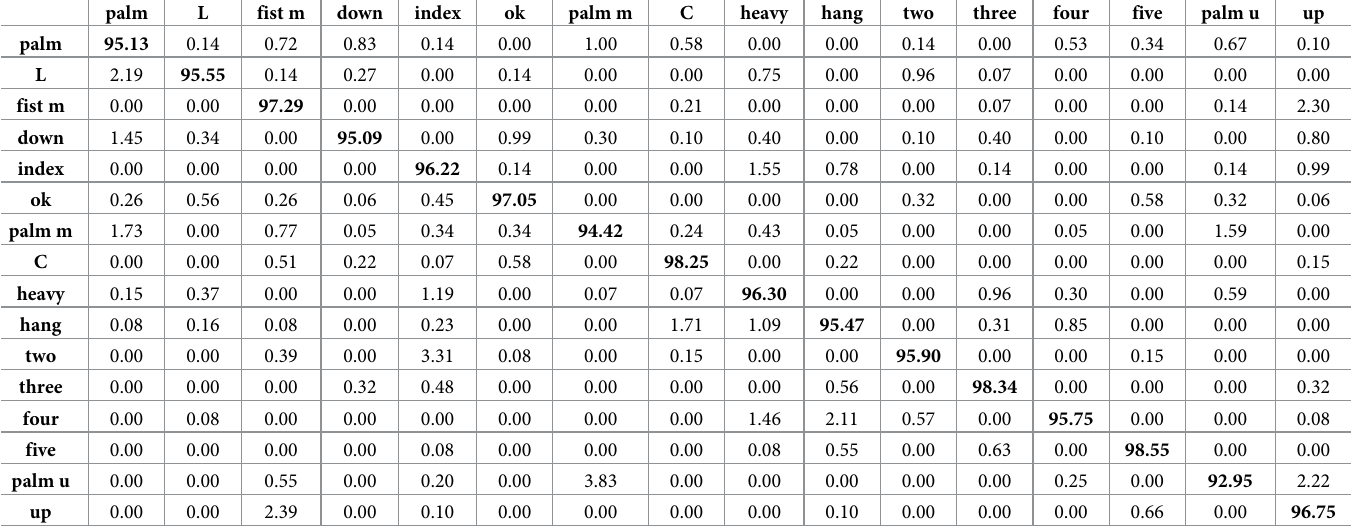
Table 1. Confusion matrix for the hand pose recognition, in percentage